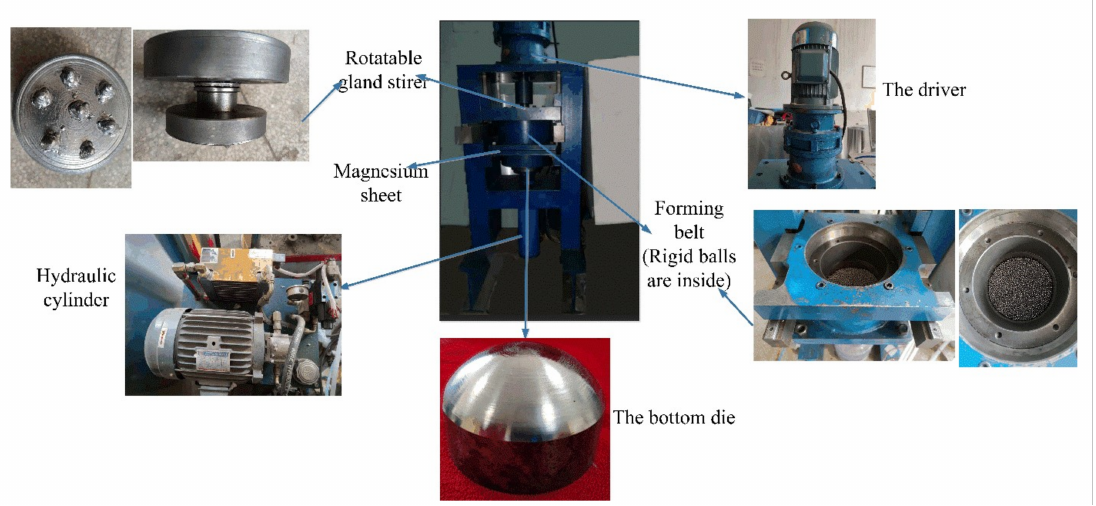
Figure 1. The device of Clustering ball